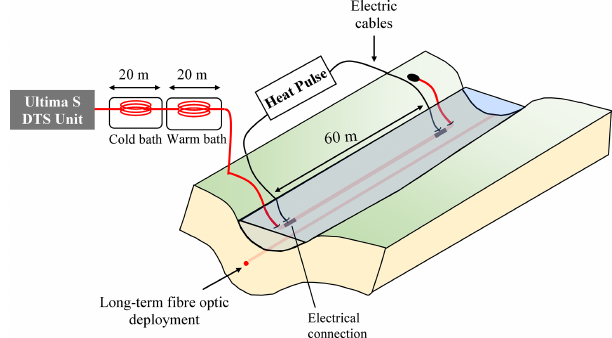
Figure 3. Experimental set-up of the active experiment. A 60m sec- tion of a heatable cable has been electrically isolated, buried in the sediments, and then heated by connecting to a power